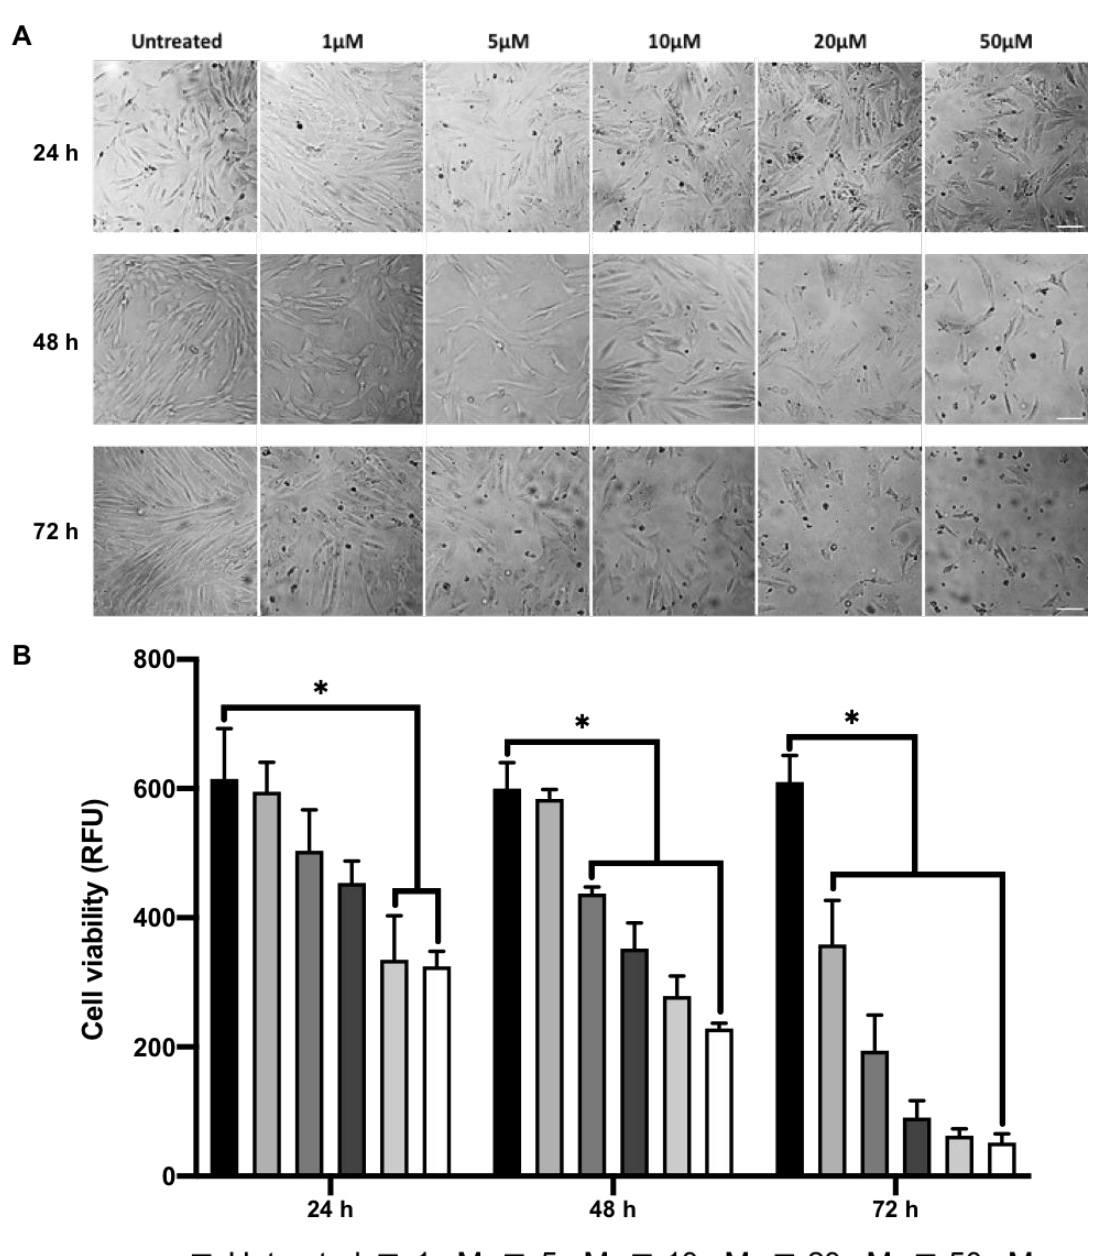
Figure 2. Effects of MI192 on hDPSCs morphology and viability. ( A ) hDPSCs morphology. Scale bar = 100 µ m. ( B ) Metabolic activity of hDPSCs, quantified with the AlamarBlue assay. Data are expressed as mean ± SD ( n = 3). * p ≤ 0.05.